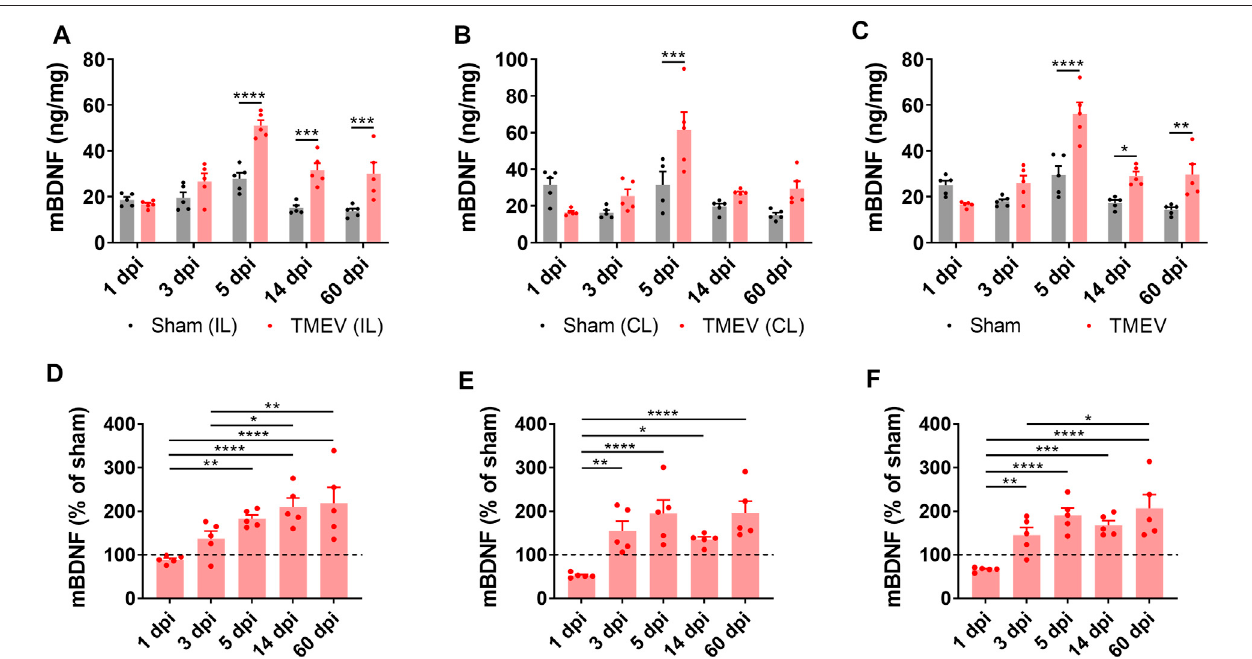
FIGURE 2 | Increase in the protein level of mature BDNF in the hippocampus of TMEV-infected mice during acute and chronic seizure period. (A-C) Absolute protein levels of mBDNF in the ipsilateral (A) , contralateral (B) , and whole hippocampus (C) are plotted at various days post-infection (dpi). (D-F) The protein level of mBDNF in the ipsilateral (D) , contralateral (E) , and whole hippocampus (F) at various timepoints after infection are normalized to their corresponding levels in the sham- treatedcontrolsamples. Dashed line at 100%on y -axis indicates mean level ofmBDNF in thesham-treated control samples. Statistics:Two-way ANOVA, Š ídák ’ s multiple comparison tests (comparison between the treatment groups at each timepoint, panels A – C ) and Tukey ’ s multiple comparisons tests (comparison between various timepoints within each treatment group, panels D – F); n = 5 mice per group at each timepoint; * p < 0.05, ** p < 0.01, *** p < 0.001, **** p < 0.0001.